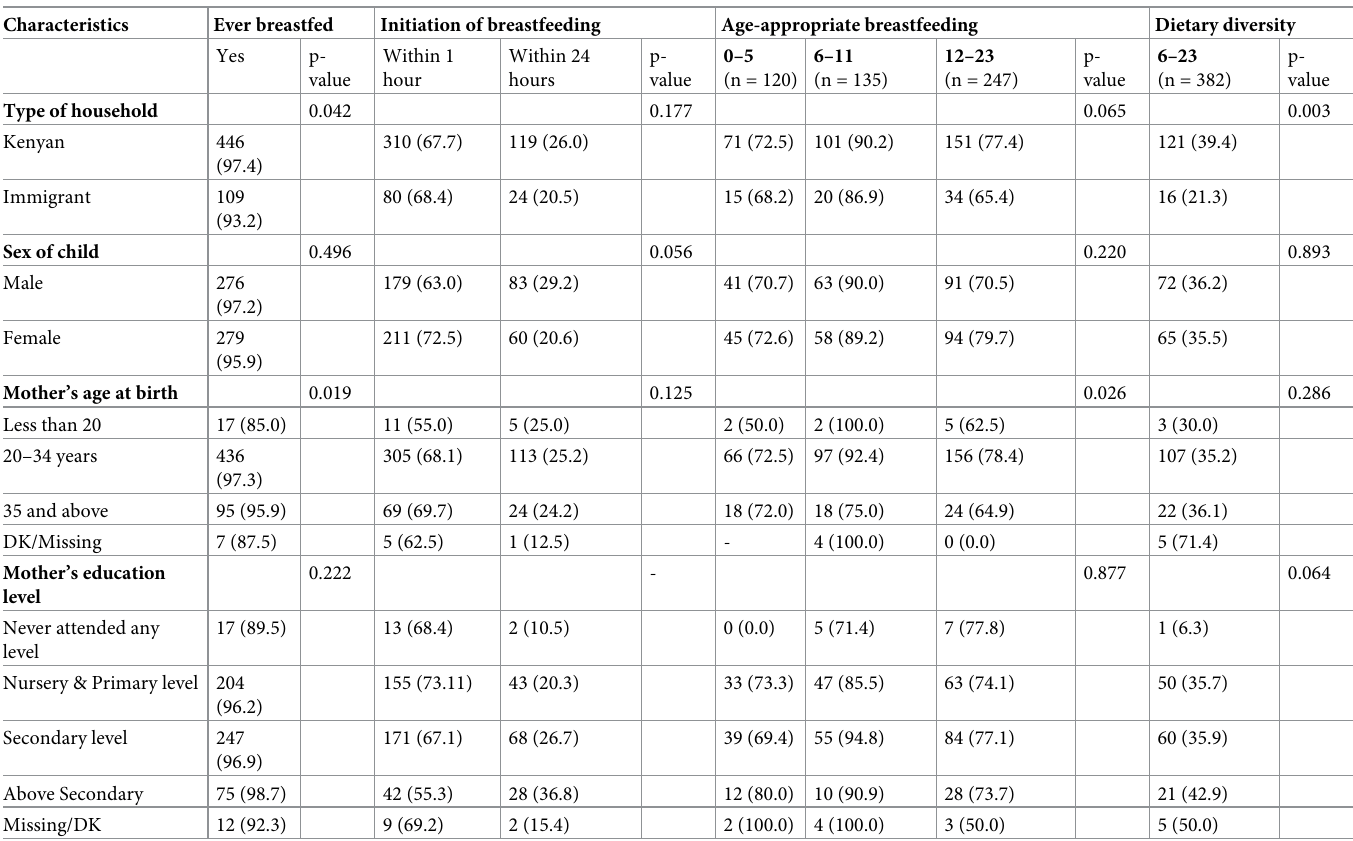
Table 5. A summary of Infant and Young child feeding practices of children ages 0–2 years.